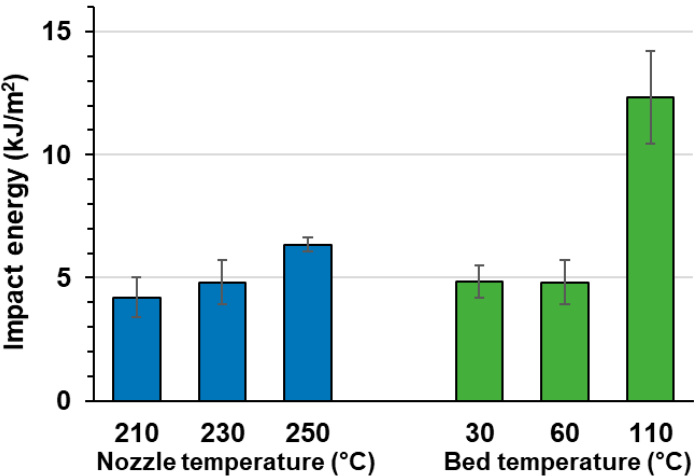
Figure 11. Influence of the nozzle temperature (210 °C, 230 °C, and 250 °C) and bed temperature (30 (30 ◦ C, 60 ◦ C, and 110 ◦ C) on the impact energy of the PLA/Hytrel-20% printed